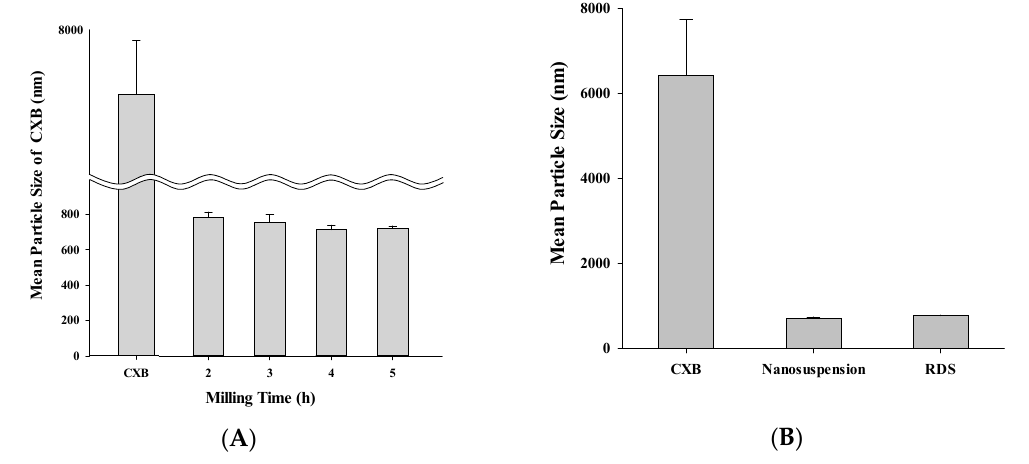
Figure 2. Mean particle size of ( A ) nanosuspension during milling process; ( B ) CXB powder, nanosuspension, and reconstituted RDS by photon correlation spectroscopy. Table 1. Physical stability of nanosuspension and reconstitutable dry suspension (RDS) ( n = 5, mean ± SD). Formulation